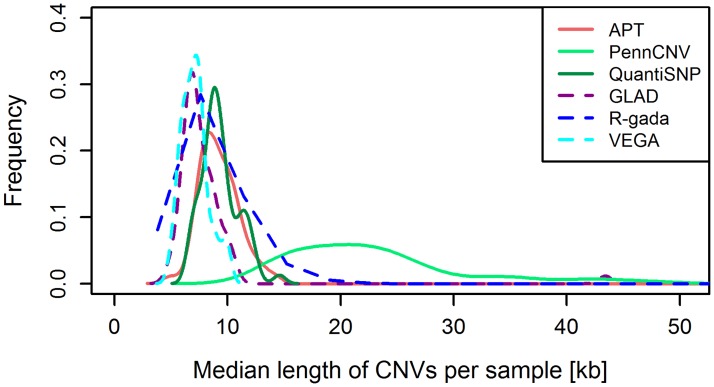
Median sample-specific CNV length.Kernel-smoothed histogram of the median CNV length per sample. Outliers were excluded. Solid line: HMM-based algorithms; dotted lines: segmentation algorithms.